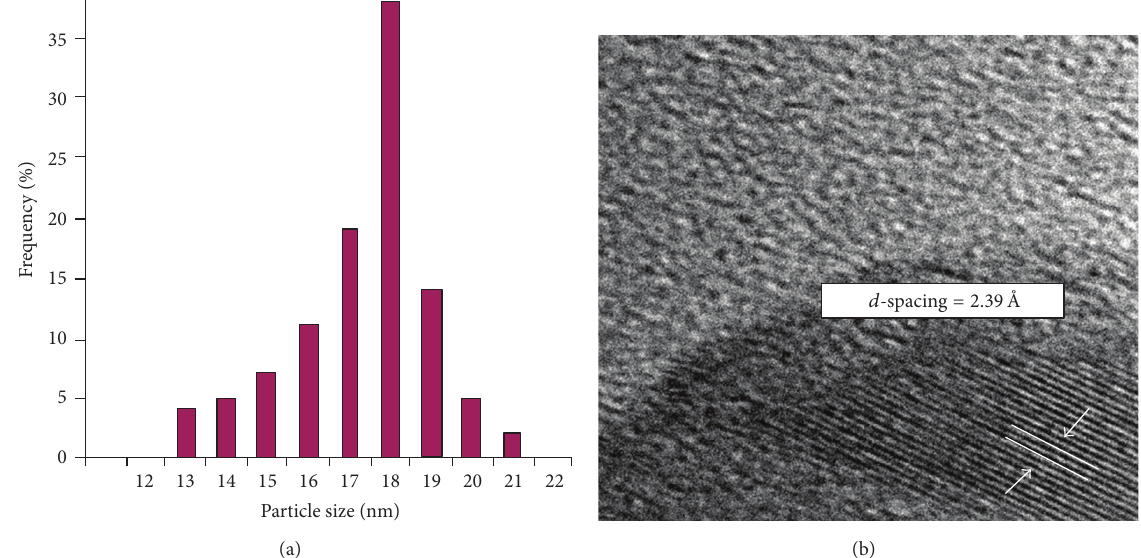
F 6: XRD pattern of AgNPs.